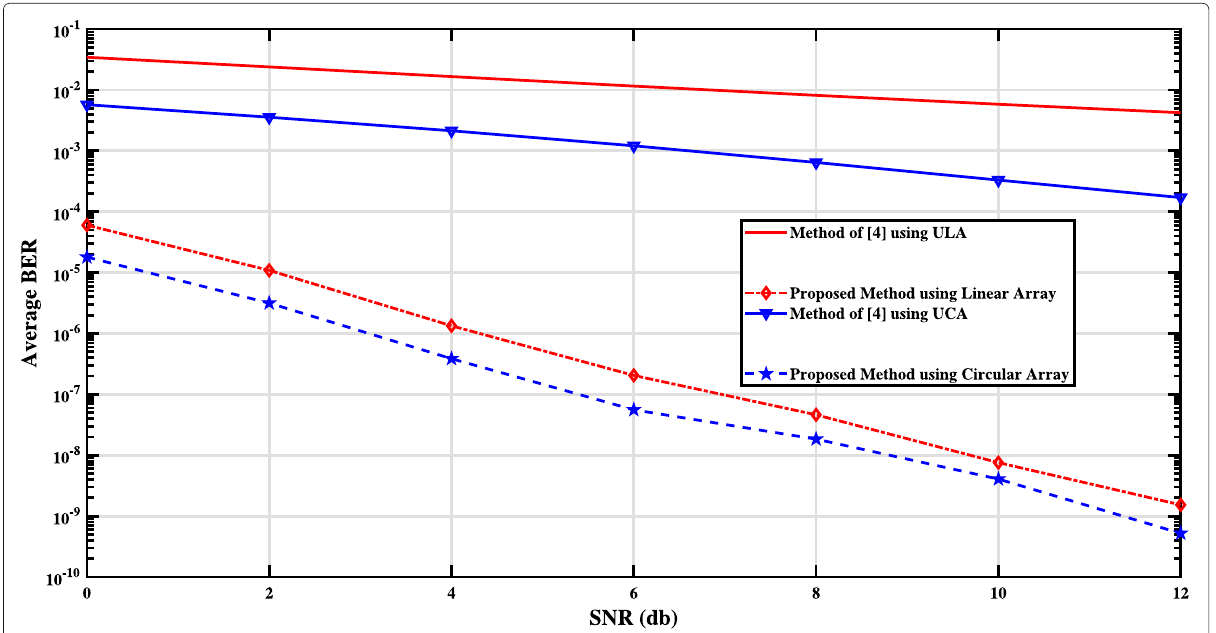
Fig. 5 Average BER performance versus SNR for Example 1 with N B = 8 and N U =